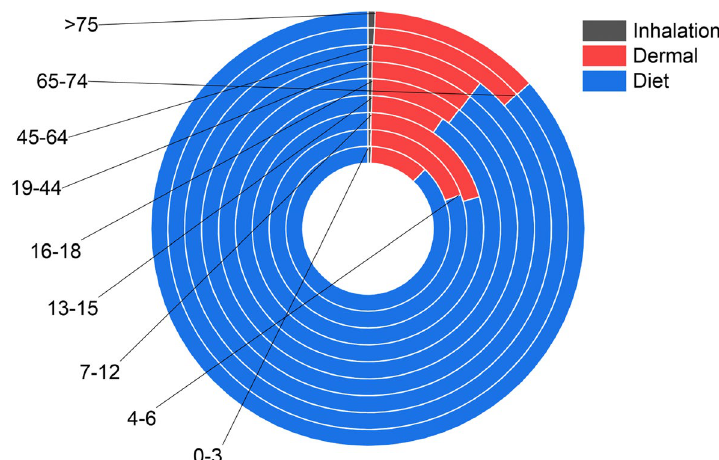
Fig. 6 Doughnut plot for the proportion of three exposure pathways across age groups (Unit: